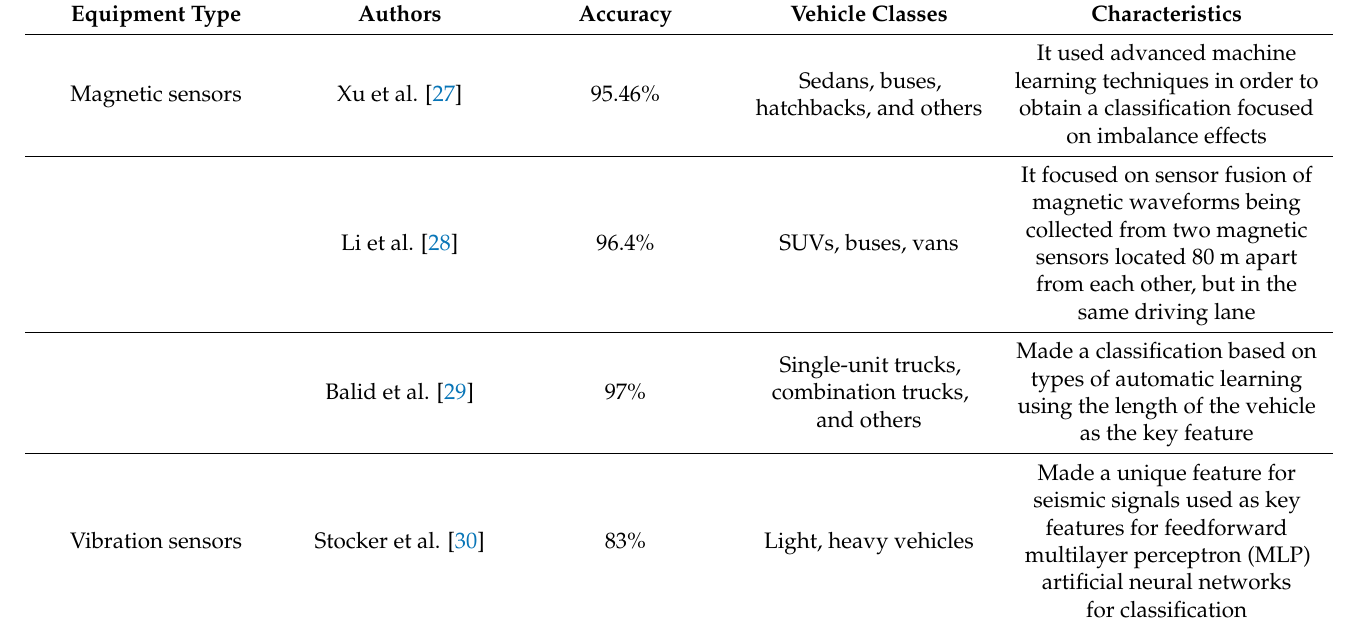
Table 1. Presentation of systems dedicated to the classification of vehicles at the in-roadway